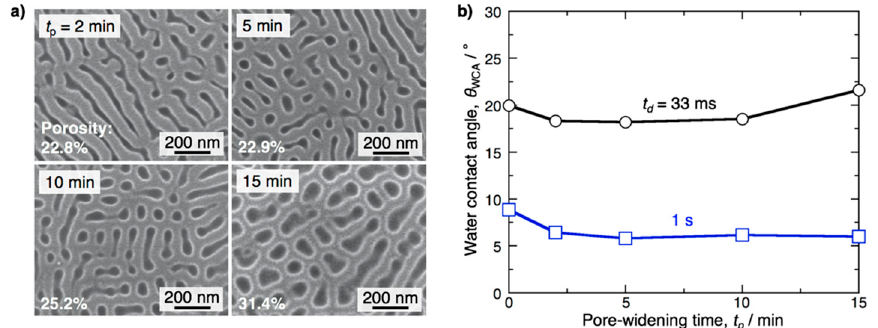
Figure 8. ( a ) SEM images of the porous alumina film formed by pyrophosphoric acid anodizing after pore-widening for t p = 2–15 min. ( b ) Changes in the water contact angle, θ WCA , with the pore-widening time, t p , at t d = 33 ms and 1 s after the water droplet was placed on the surface.